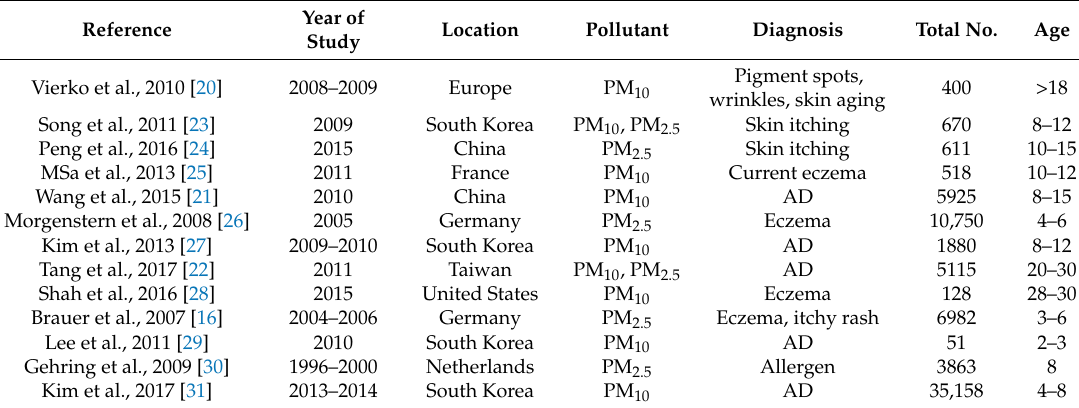
Table 1. Summary characteristic of studies. AD: atopic dermatitis; PM: particulate matter.